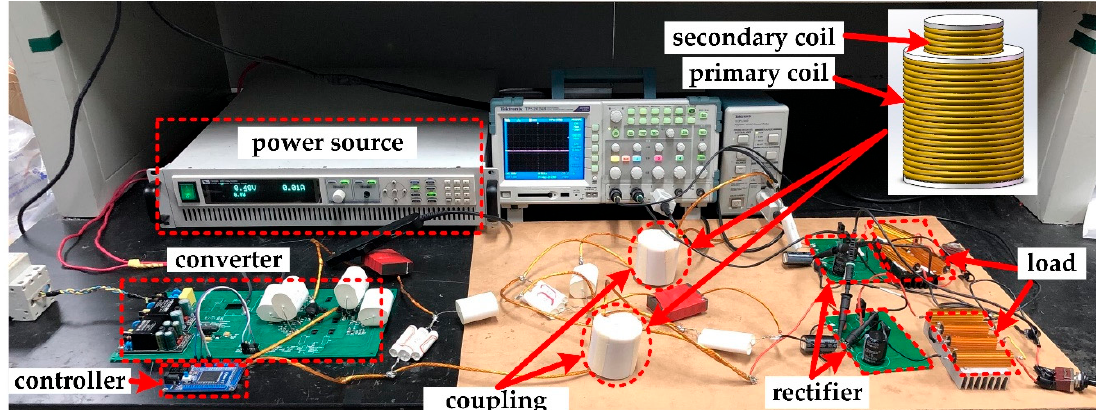
Figure 11. The flowchart of the topology parameter design.